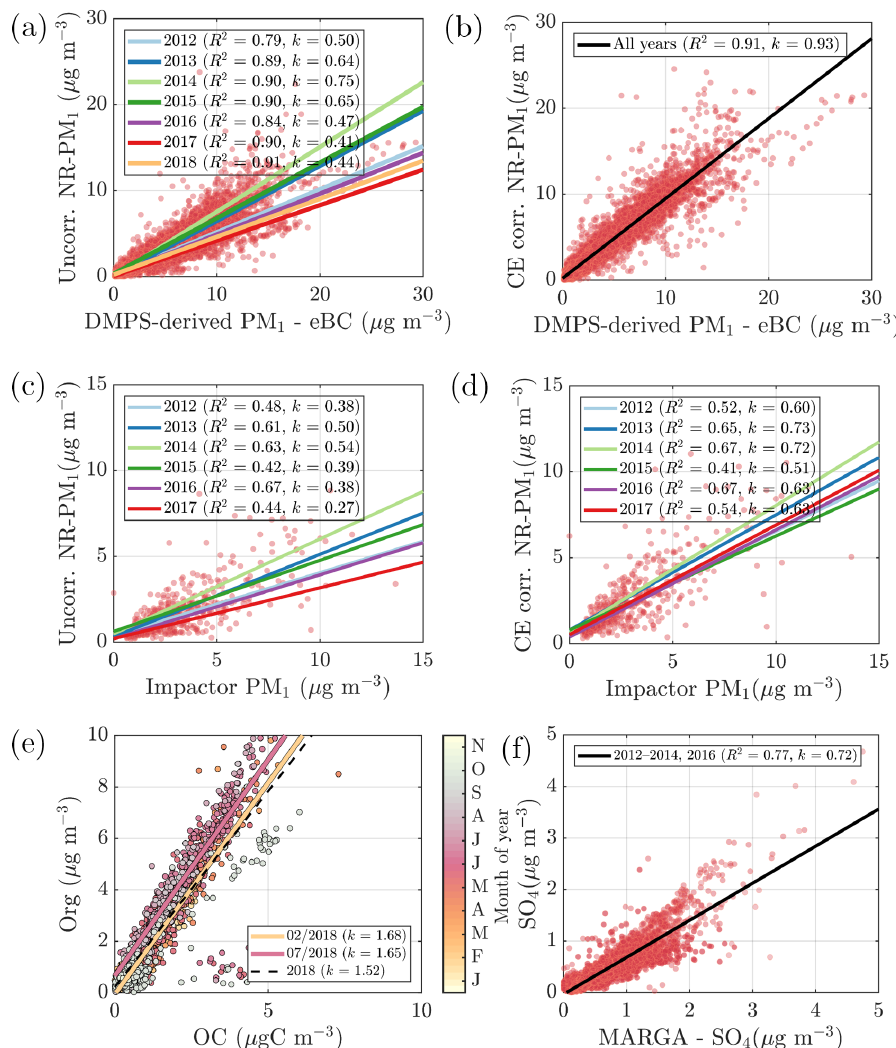
Figure 2. (a) The NR-PM 1 mass concentration without collection efficiency (CE) correction vs. the DMPS-derived eBC subtracted mass concentration. The linear fits are displayed with solid lines for each year. The slopes of the linear fits ( k ) and Pearson correlation coefficients ( R 2 ) are presented in the figure legend. (b) CE-corrected NR-PM 1 mass concentration vs. the DMPS-derived eBC subtracted mass concen- tration. The black line represents the overall linear fit. (c) The NR-PM 1 mass concentration without collection efficiency (CE) correction vs. the Dekati impactor PM 1 concentration. The linear fits are displayed with solid lines for each year, respectively. (d) CE-corrected NR-PM 1 mass concentration vs. the Dekati impactor PM 1 concentration. The linear fits are displayed with solid lines for each year. (e) The ACSM organics vs. the PM 2 . 5 organic carbon (OC) detected with a semicontinuous OC/EC analyzer. The dashed black line repre- sents the overall linear fit (Pearson R 2 = 0 . 72), and the solid orange and pink linear fit lines represent the February and July fits, respectively. The color coding indicates the month of the year in 2018. (f) The ACSM sulfate vs. the PM 2 . 5 sulfate detected with MARGA-2S. The black line represents the overall linear fit. In all of the panels, dots represent all the measurement points collected in the course of the measurement